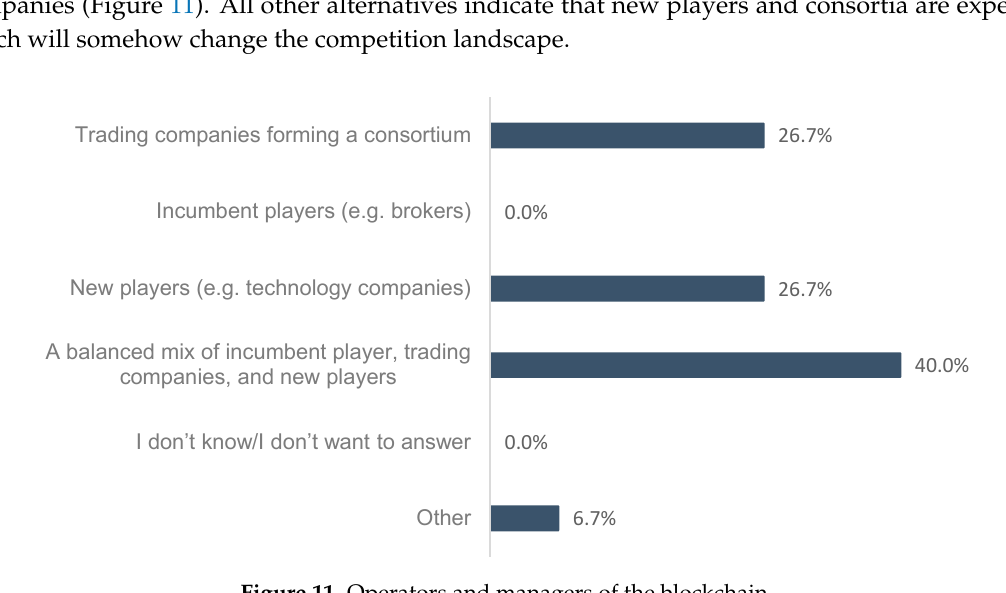
Figure 11. Operators and managers of the blockchain.